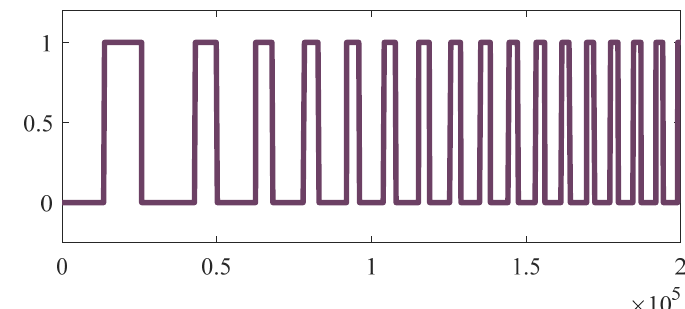
Figure 11. PWM-PWM commutation logic triggering pulses.